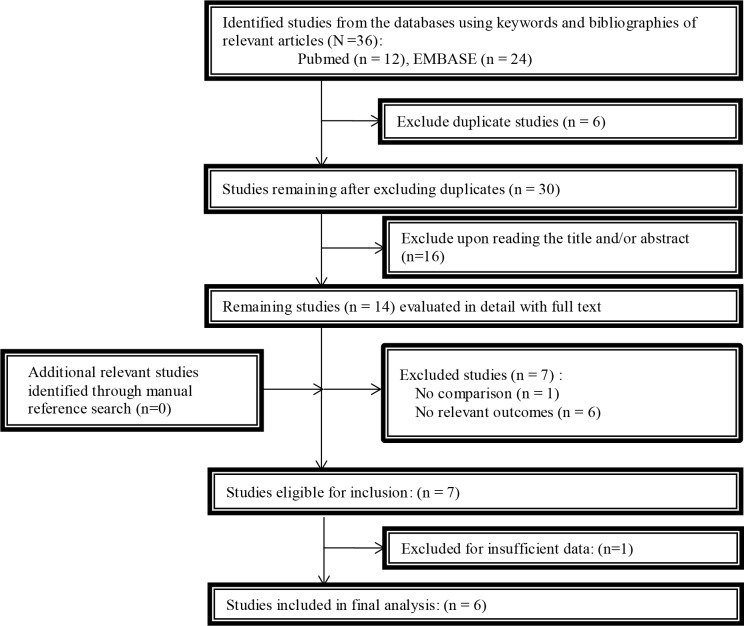
Flow chart of the study selection process.